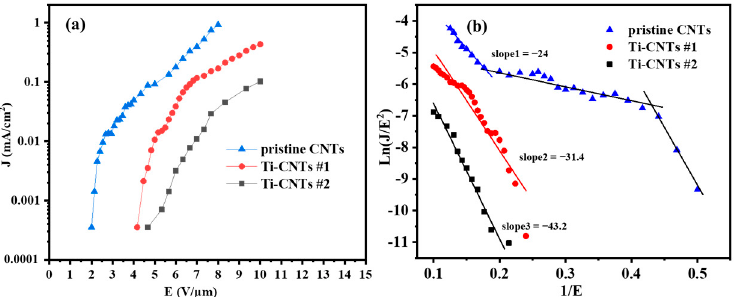
Figure 6. Field emission performance of different emitters. ( a ) J ‒ E electron emission properties, and ( b ) F ‒ N plots of these data.